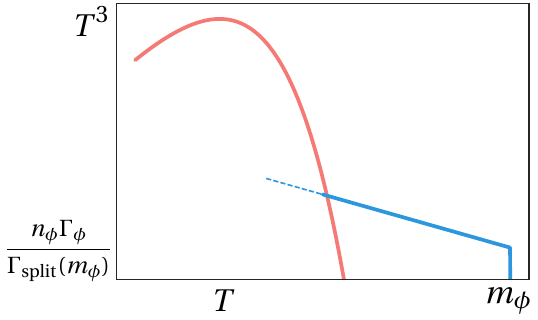
Figure 1 . A schematic plot of n ( E ) as a function of E . While the red curve shows the thermal distribution given in eq. (2.11), the blue curve shows the high-energy tail given in eq. (2.10). The temperature at t = t , which is commonly called as the reheating temperature, is RH given